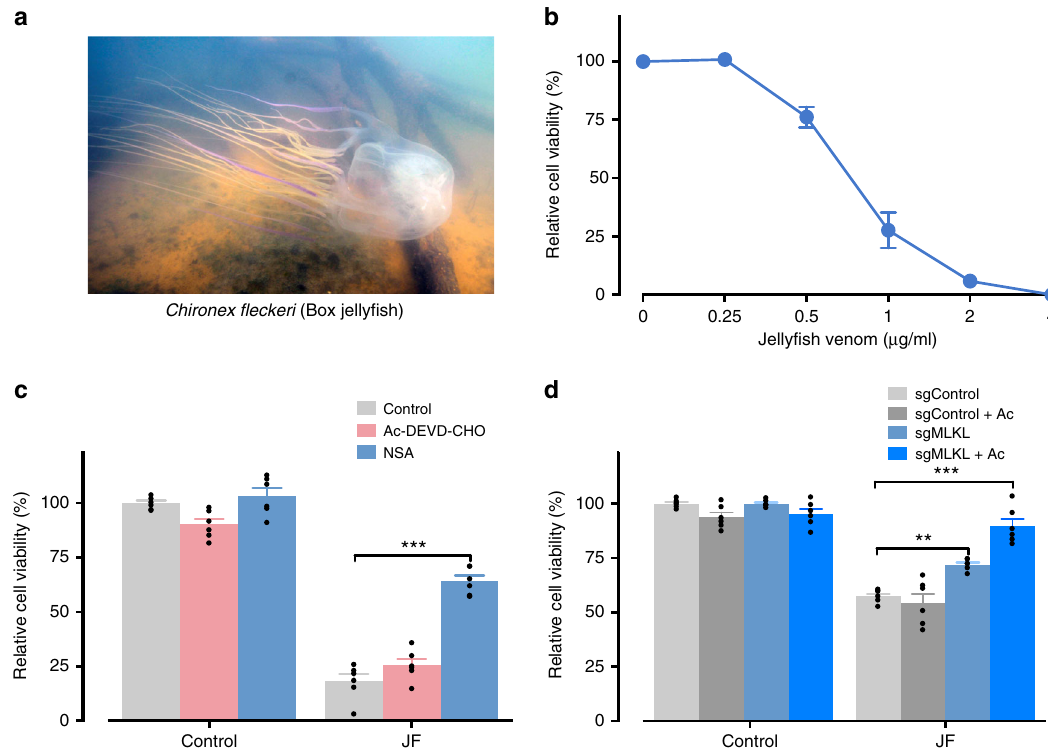
Fig. 1 Box jelly fi sh venom induces a predominantly necrotic cell death. a Mature C. fl eckeri jelly fi sh. b HAP1 cells were treated with vehicle or different concentrations of jelly fi sh venom (as indicated) for 24 h, and cell viability was then determined by resazurin-based cell viability assay ( n = 3). c Inhibition of MLKL by necrosulfonamide (NSA; 5 μ M), but not caspase inhibition by Ac-DEVD-CHO (10 μ M), reduces the jelly fi sh venom (1 µ g/ml) induced cell death ( n = 6). d Depletion of MLKL conferring resistance to jelly fi sh venom in HAP1 cells. Inhibition of caspase by Ac-DEVD-CHO (Ac) in MLKL-depletion (sgMLKL) cells protects the jelly fi sh venom (0.75 µ g/ml) induced cell death in a synergistic manner ( n = 6). All data represented as mean ± S.E.M. one-way ANOVA followed by Tukey ’ s post hoc test, ** p < 0.01; *** p <